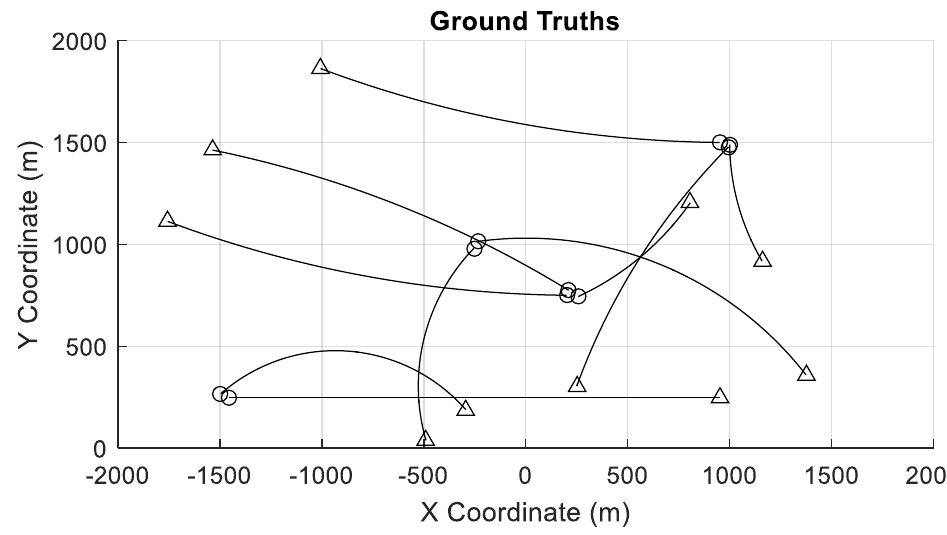
Figure 3. Multiple-target trajectories in the x − y plane. Starting and stopping positions are indicated with and (cid:52) , respectively. Targets become more dispersed over time. (cid:35)